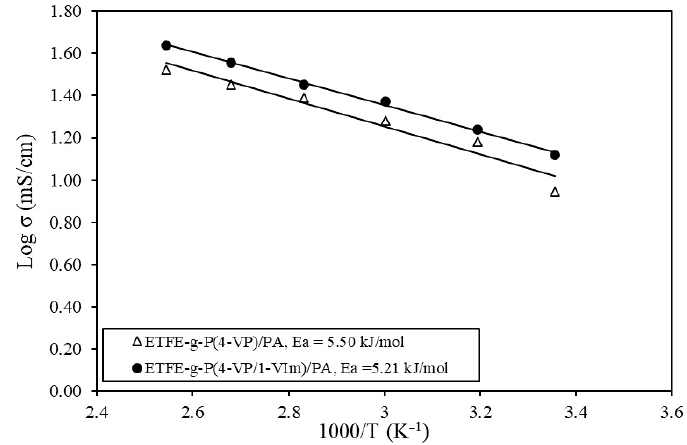
Figure 13. Arrhenius plots for proton conductivity vs. reciprocal of temperature for PA doped membranes.